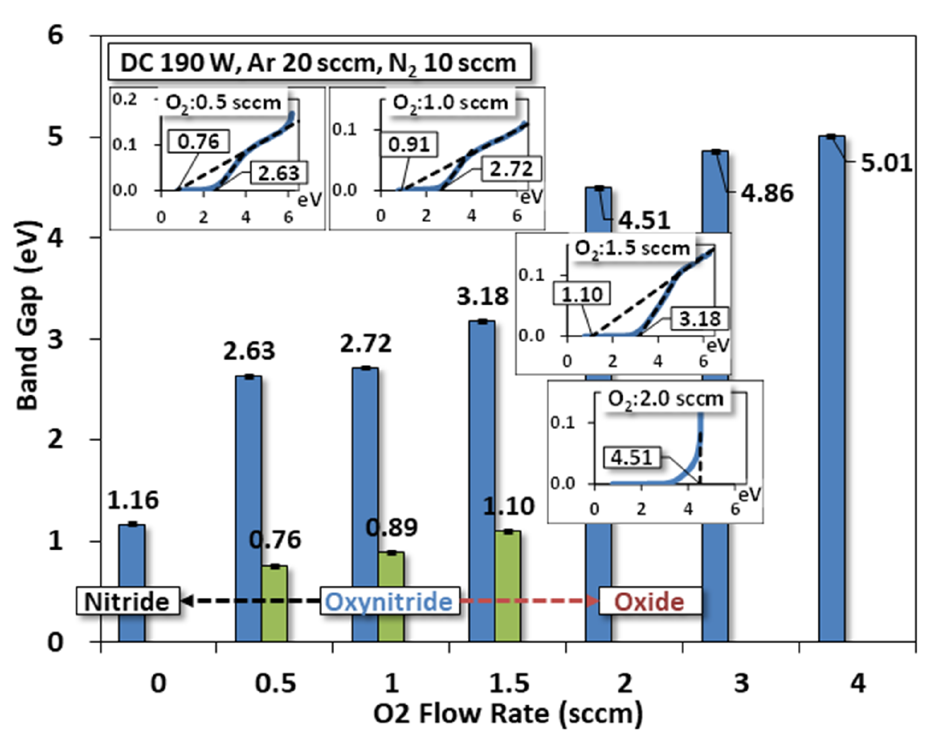
Figure 8. Estimated optical band gaps in annealed films based on the UV-Visible-NIR spectra using the Tauc plot.